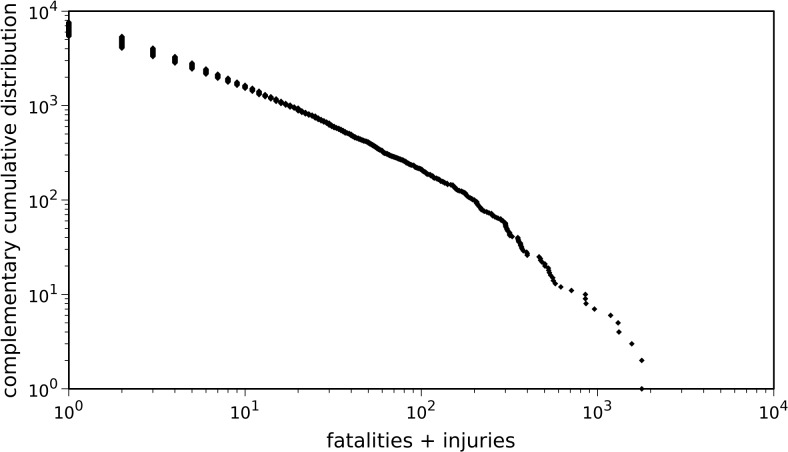
Complementary cumulative distribution of fatalities plus injuries.All reported tornadoes that occurred in the U.S., during the time period 1950–2013 are considered.